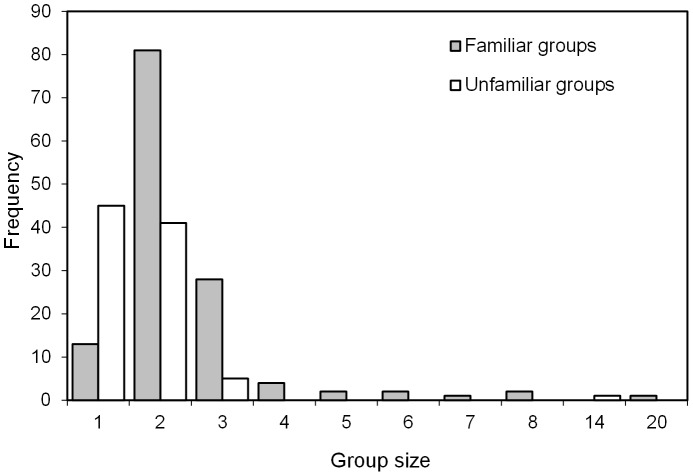
Frequency distribution of group sizes recorded for familiar and unfamiliar humpback whales groups off west South Africa.Familiar groups contained at least one resighted whale, and unfamiliar groups contained no resightings.